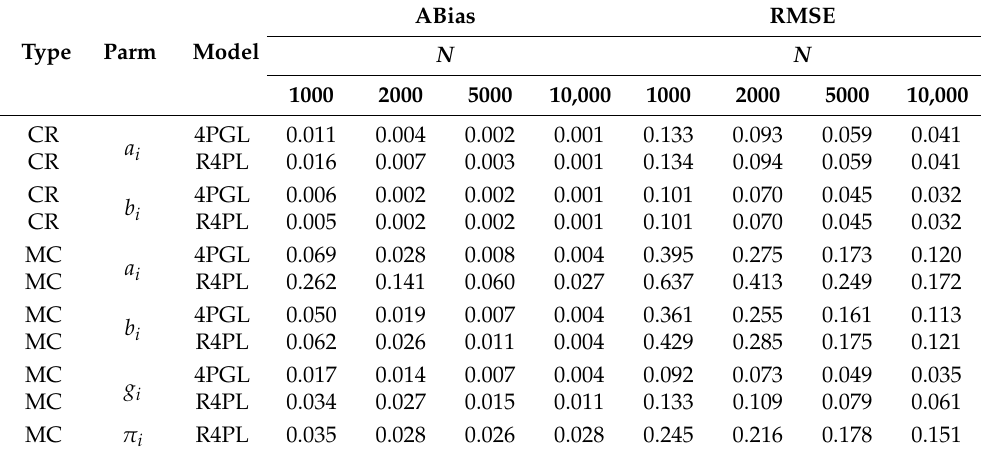
Table 2. Simulation study: average absolute bias (ABias) and root mean square error (RMSE) of estimated item parameters in the 4PGL and R4PL models as a function of sample size N .